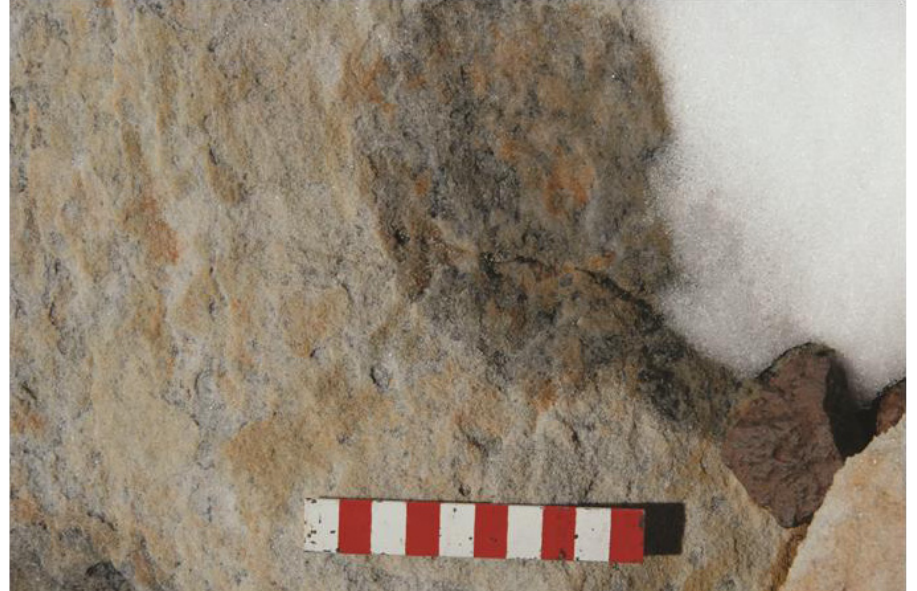
Figure 2. Snow melting on a moderately-sloped boulder top on Battleship Promontory. Melting occurs in summer around noon, when insolation is maximal. (Scale 10 cm).